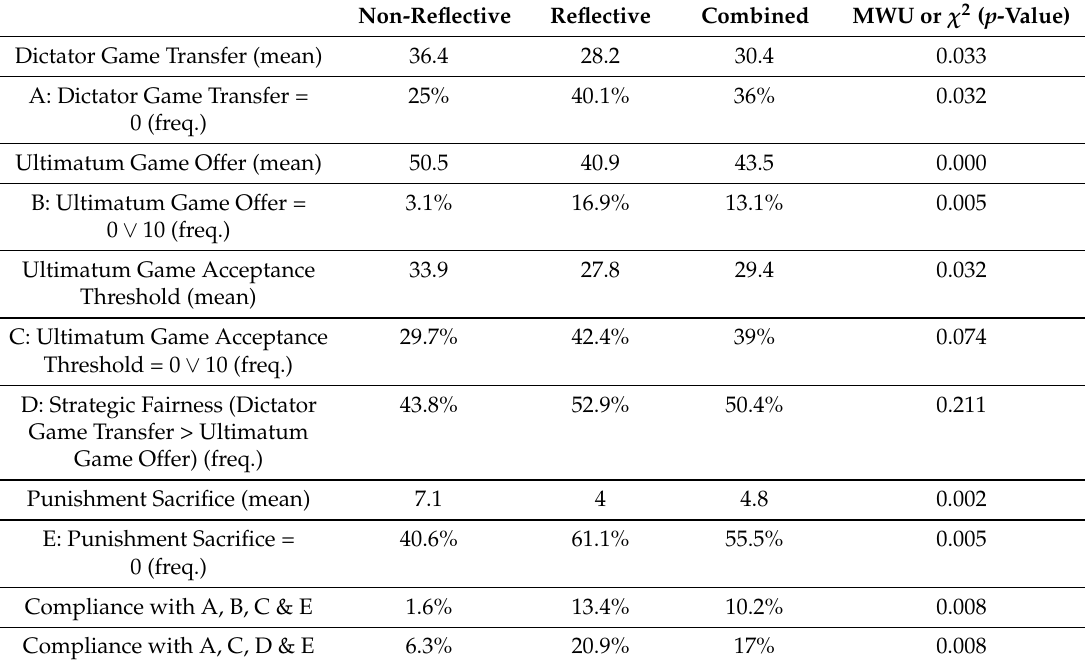
Table A16. Results by Non-Reflective (Reflective)